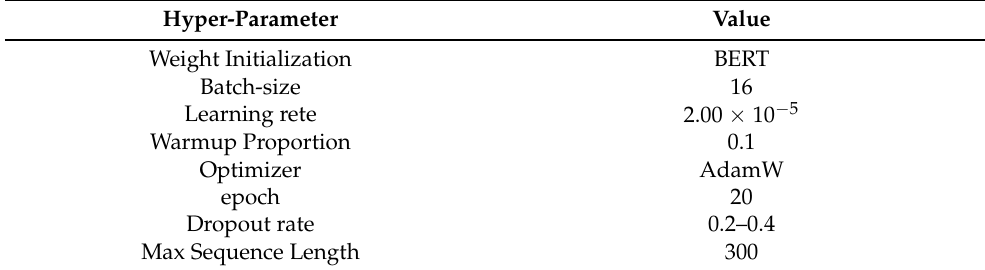
Table 3. Hyperparameters of the model, where the ACE2004 and ACE2005 datasets use BERT-base- uncased and GENIA uses